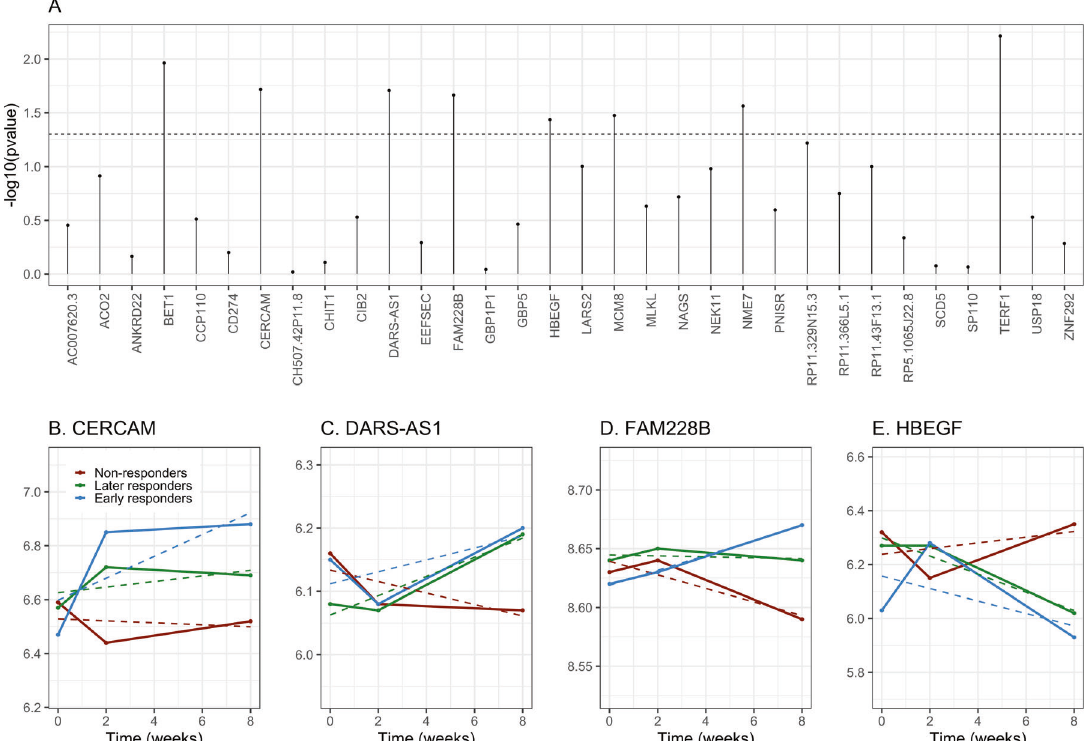
Fig. 2 Relationship between change over time and response to escitalopram treatment. A Association between change over time (slope) of the 32 selected RNAs and response to escitalopram treatment at T8. The p values (log10 transformed, y -axis) for the association between response status and RNA slope are shown for each of the 32 selected RNAs ( x -axis). The dotted line represents the threshold of P < 0.05 used to select RNAs for the next analysis steps. B – E Change over time of the 4 signi fi cant RNAs by response to escitalopram treatment. Expression trajectories over time are shown for CERCAM B , DARS-AS1 C , FAM228B D , and HBEGF E among individuals classi fi ed as early responders, later responders, and nonresponders. Solid lines and points represent observed means, dashed lines represent linear